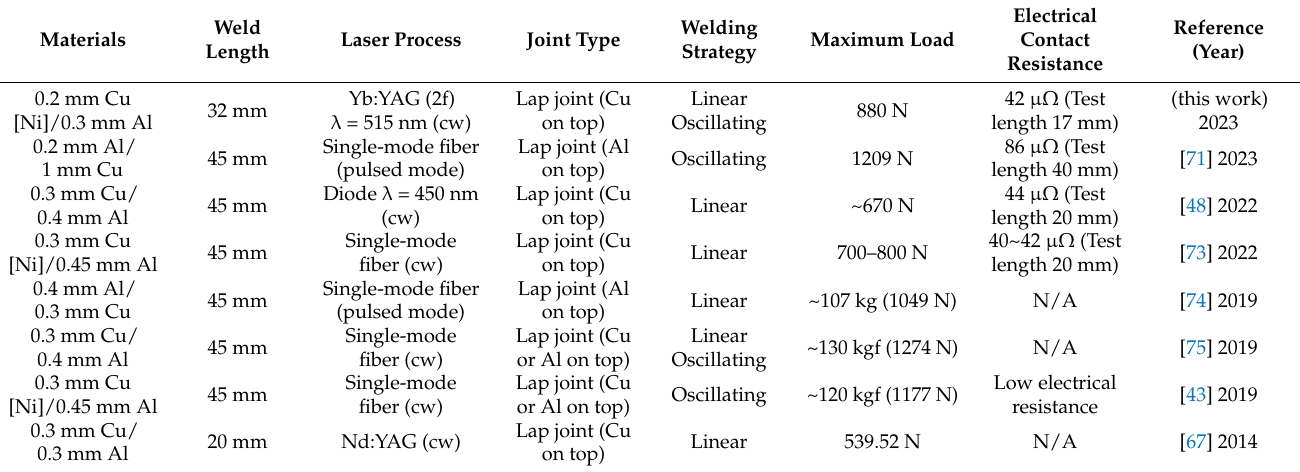
Table 7. Summary of research conducted on laser beam welding of copper and